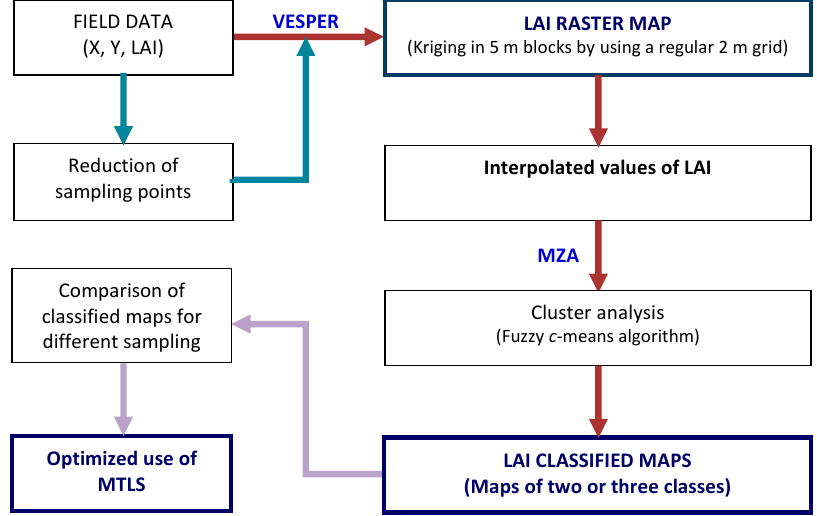
Figure 7. Flowchart for obtaining and comparing LAI raster maps.